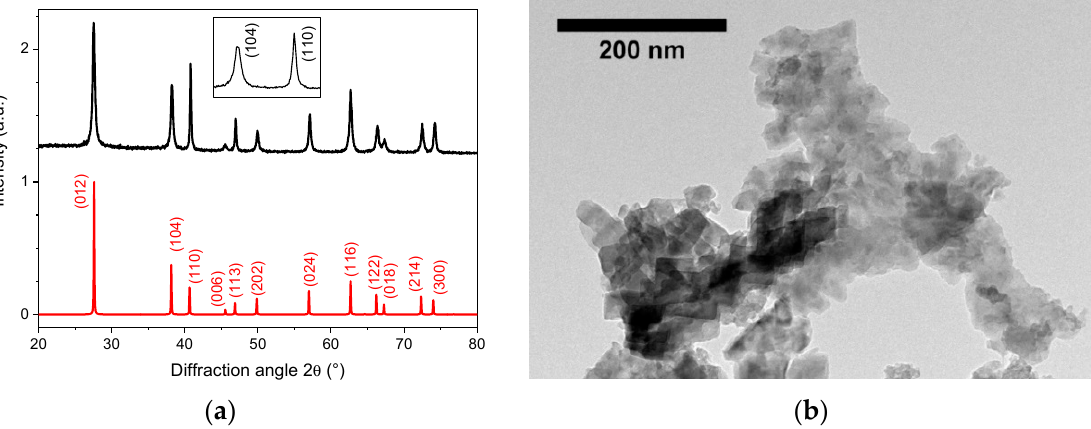
Figure 1. ( a ) XRD diffraction pattern of lithium niobate (LN) nanoplatelets after thermal decomposition of lithium niobium ethoxide in its parent alcohol. The reactant concentration was 0.135 M, and the different peak broadening is illustrated in inset for the (104) and (110) reflections. ( b ) Corresponding TEM image of LN nanoplatelets for which the anisotropic factor defined as S 110 /S 006 was above 8.3. Table 1. Apparent nanocrystal sizes, S hlk (in nm), from the Scherrer’s formulae for LN nanoplatelets after thermal decomposition of lithium niobium ethoxide in its parent alcohol for 3 days at 230 °C.